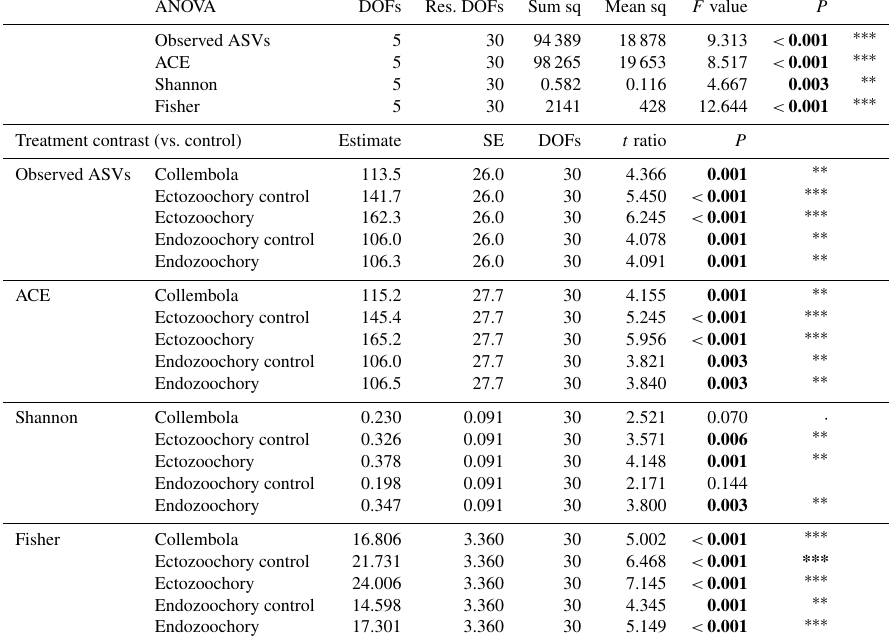
Table C2. Effects of Collembola additions on bacterial alpha diversity (ANOVAs and pairwise contrasts), with total number of observed ASVs, abundance-based coverage estimator (ACE), and Shannon’s and Fisher’s diversity indexes. Holm adjustment for P values of pairwise contrasts. P values below 0.05 are denoted in bold; ∗∗∗ P < 0.001; ∗∗ 0.001 <P < 0.01; ∗ 0.01 <P < 0.05; dot ( · ) denotes 0.05 <P <